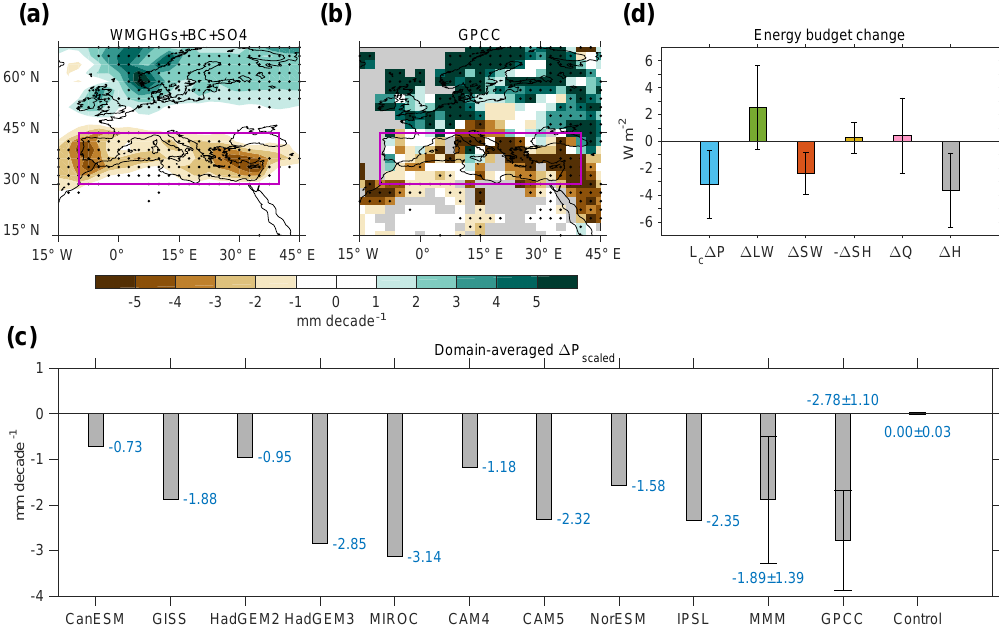
Figure 6. Scaled change for the combination of WMGHGs, BC and SO 4 for (a) spatial pattern of precipitation, (c) domain-averaged pre- cipitation change and (d) energy budget change, along with 1901–2010 (b) GPCC observational data (for which gray indicates missing or incomplete data). The dots in panels (a) and (b) indicate changes are significant at 0.95 and 0.9 confidence level, respectively. Error bars in panels (c) and (d) indicate 90% uncertainty